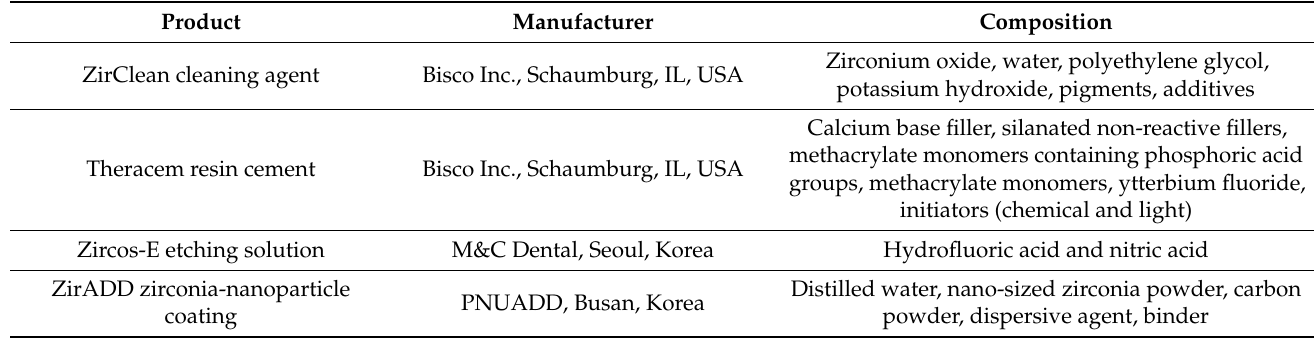
Table 1. Material